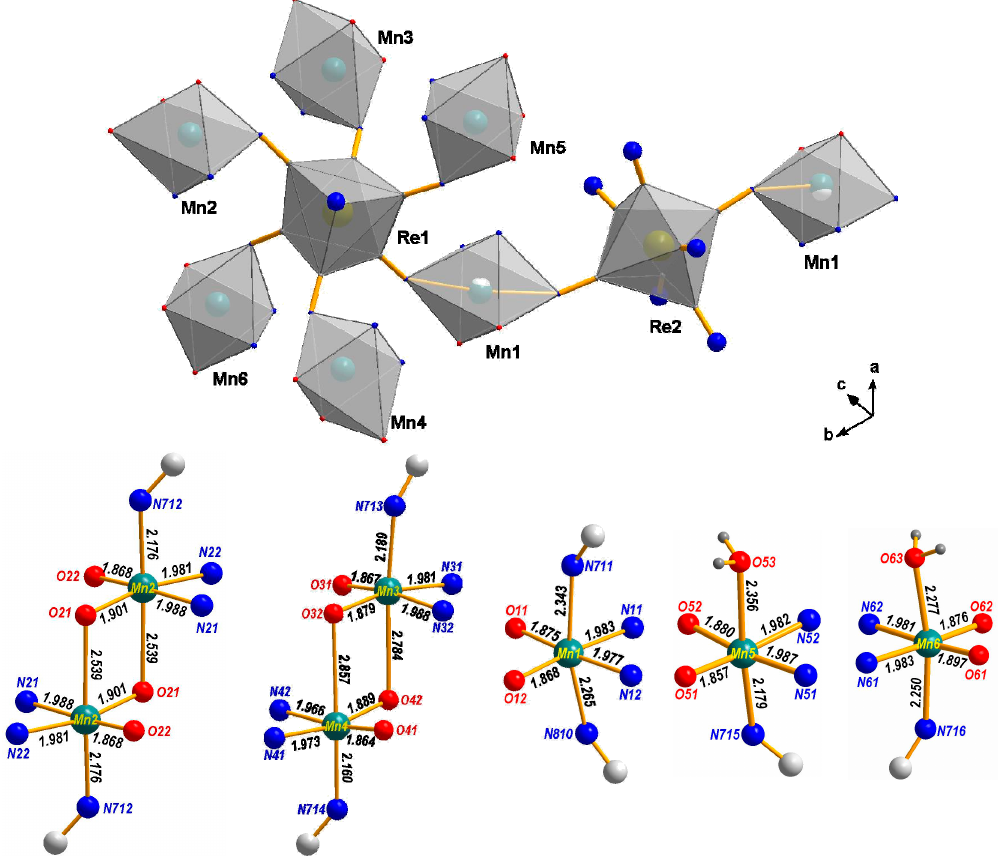
Figure 5. The coordination polyhedra in 4 . The equatorial planes of the axially elongated octahedrons are composed of {OONN} atom set of SB ligand.